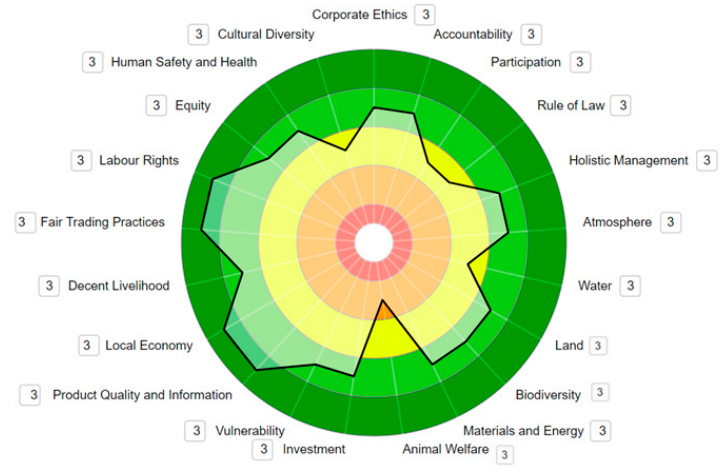
Figure 6. SAFA assessment result of the start-up as spider graph. The number near indicators suggest the data quality according to Table 4, and also, the colour in the circles represent the range score. As reported in Table 3, the colour means the performance score: Dark green: Best; light green: Good; yellow: Moderate; orange: Limited; red: Unacceptable. High scores in environmental and management indicators are due to the deep implementation of digital production tools.